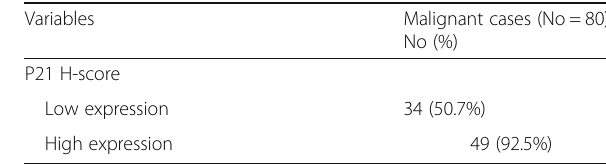
Table 2 Immunohistochemical profile of the studied ROC- 1,CAIX and p21 in the studied bladder carcinoma cases